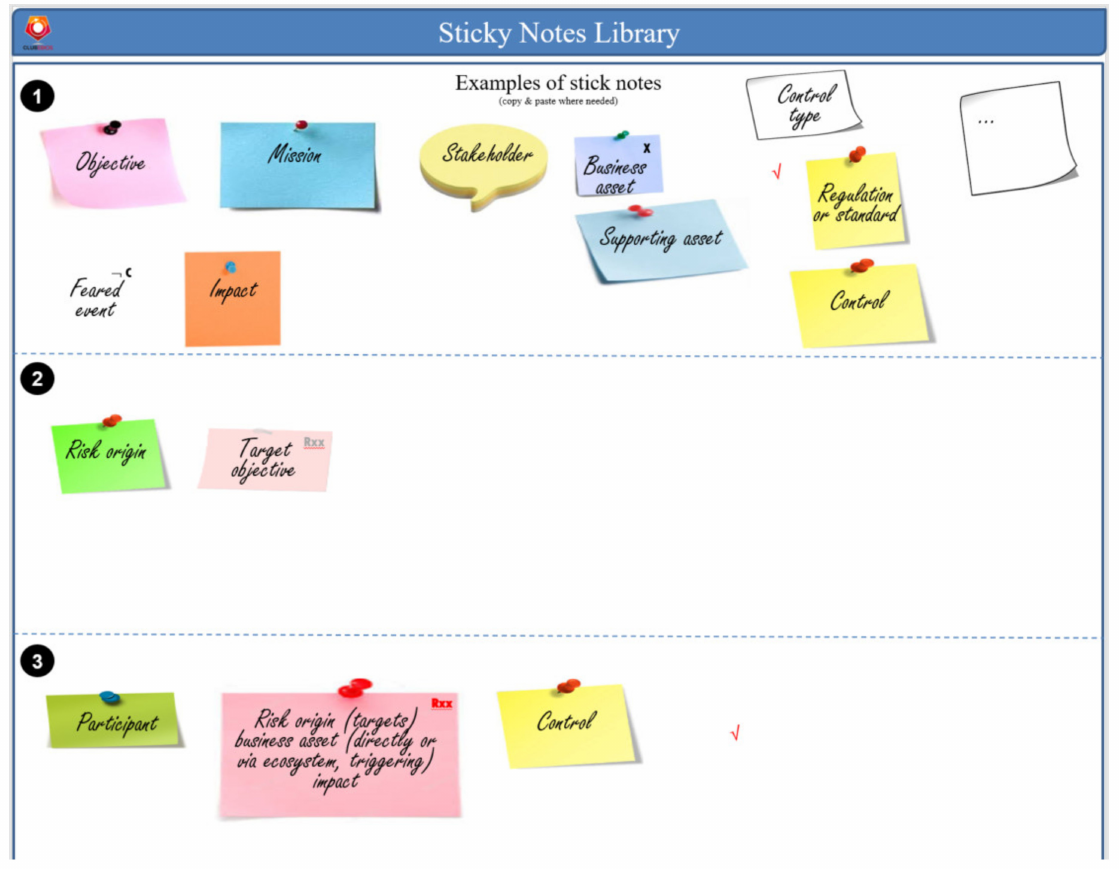
Figure A2. Stick notes library